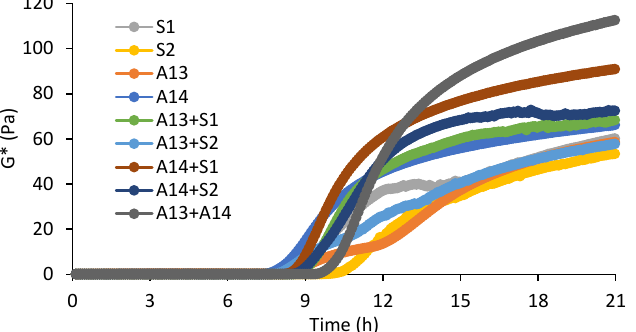
Figure 3. Changes in complex modulus during the fermentation of skimmed milk by two wildtype L. lactis strains, A13 and A14, in comparison to commercial starter cultures, S1 and S2, and in combined application.